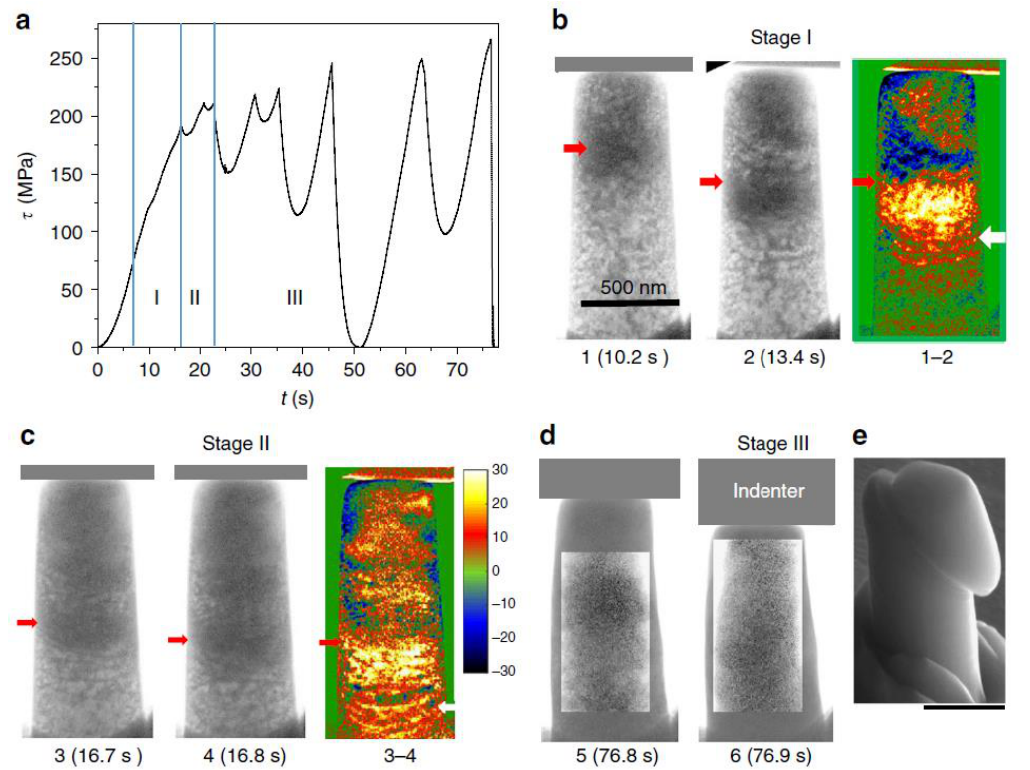
Figure 24. The in situ nanomechanical indentation and TEM results for the Al 0.1 CoCrFeNi HEA in terms of the ( a ) stress vs. time data (stages I, II, and III labeled in the figure), the TEM imaging results for the serrations that occurred during ( b ) stage I, ( c ) stage II, and ( d ) stage III (with color-coded deformation stages), and ( e ) the SEM image of the deformed nanopillar that confirms that large crystal-slip ensued during the experiment (reproduced from Reference [160]).